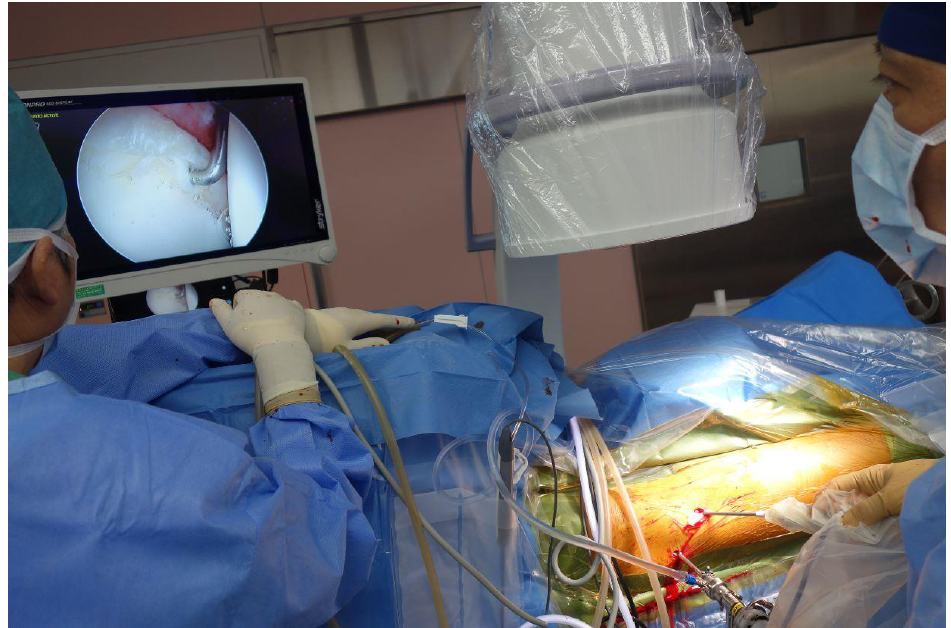
Figure 2. The surgeon (on the right) is measuring the resistance force of the labrum with the probing device. The process is directly observed on the monitor.